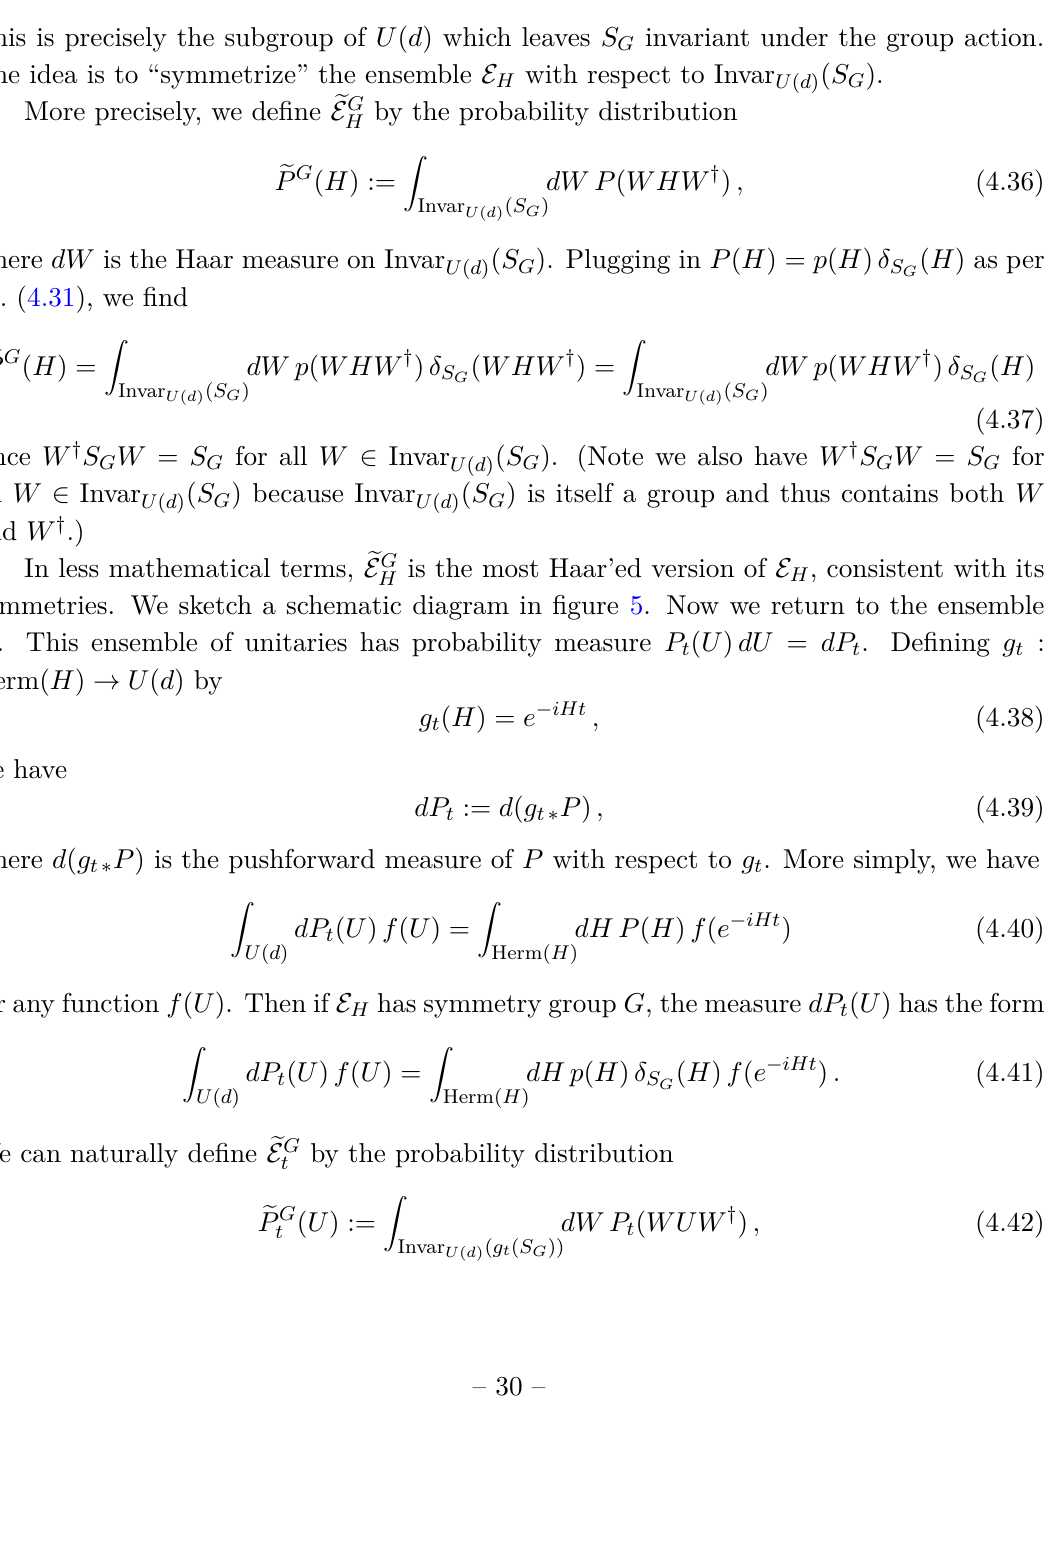
Figure 5 . S G completely contains the G -Haar’ed Hamiltonian ensemble e E G blue